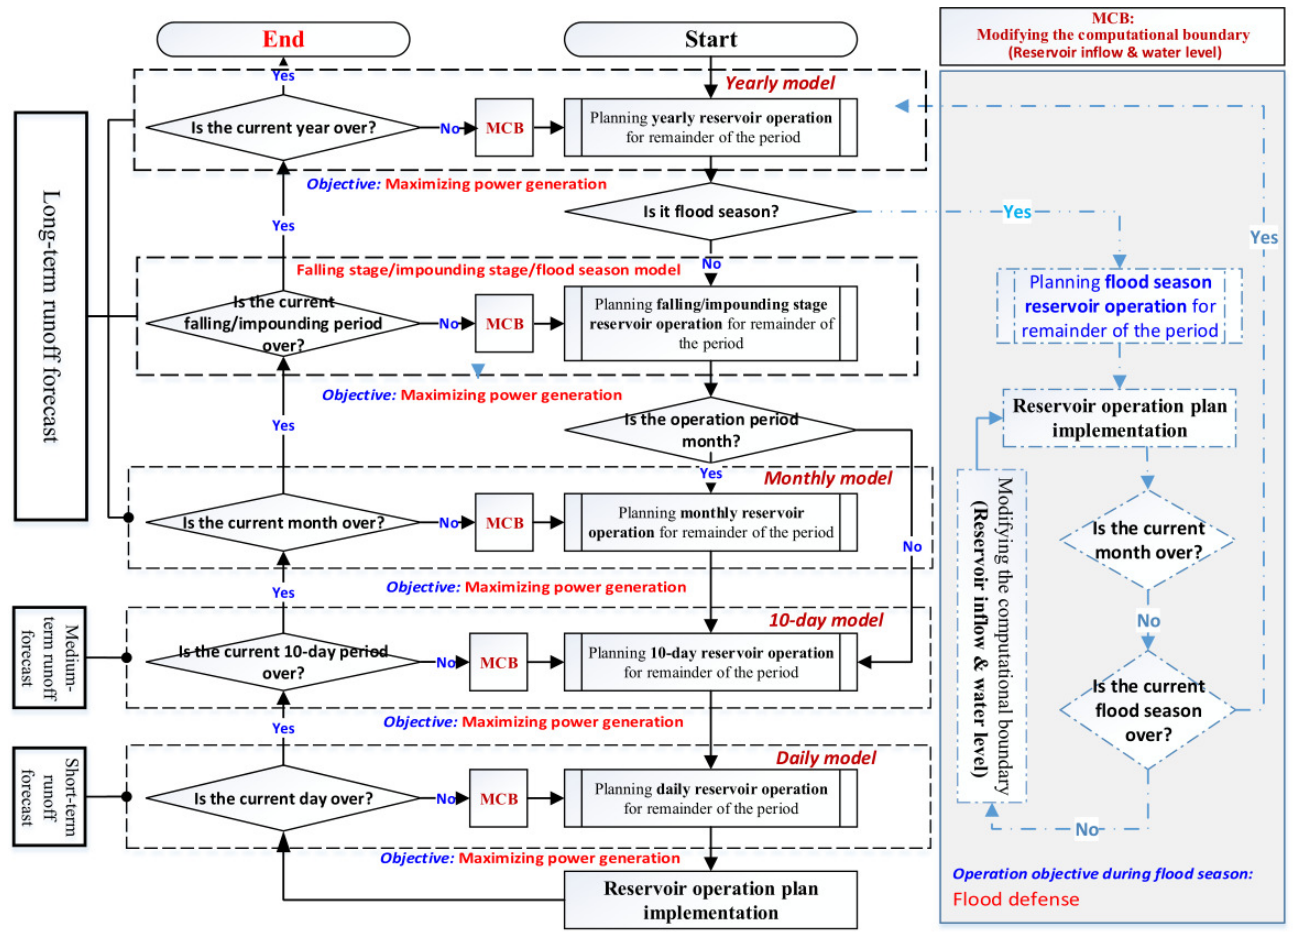
Figure 3. Flowchart of the nested scheduling